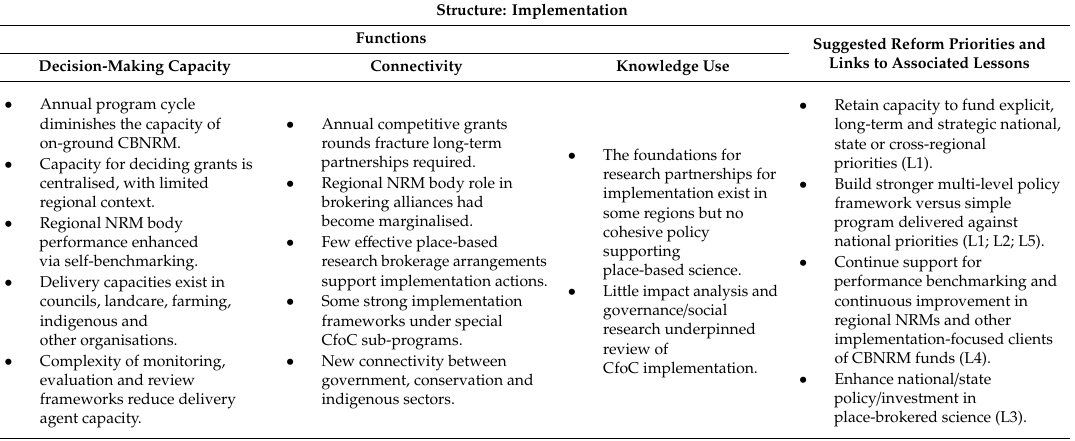
Table 5. A synthesis of findings regarding national aspects of implementation in Australia’s CBNRM governance system.